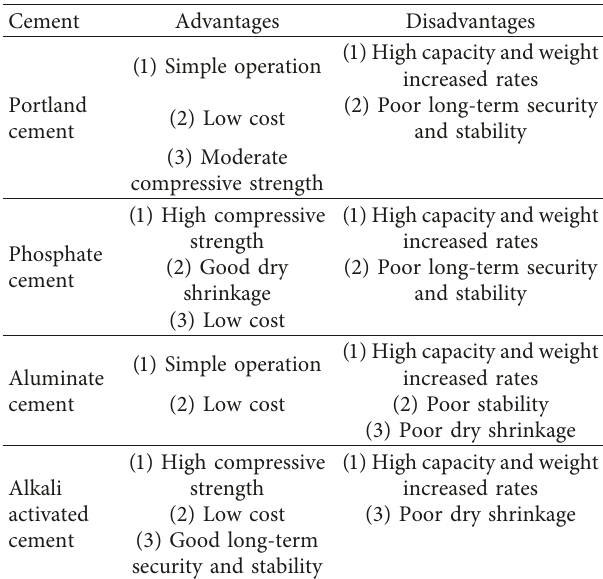
Table 2: Chemical speciation of heavy metals in MSWI fly ash. Heavy metal